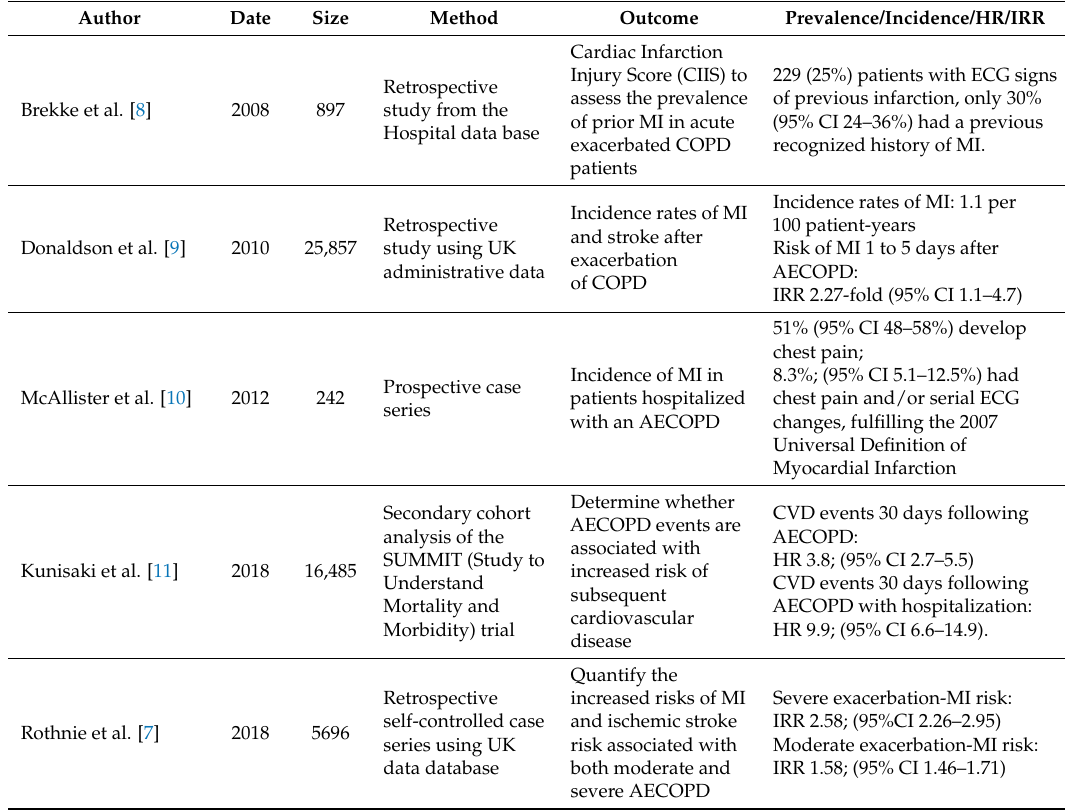
Association between acute exacerbations of COPD and acute coronary events: epidemiological